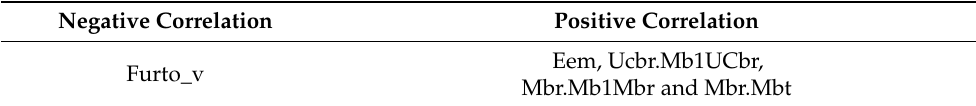
Table 3. Correlation with the inconsistent expected sign.